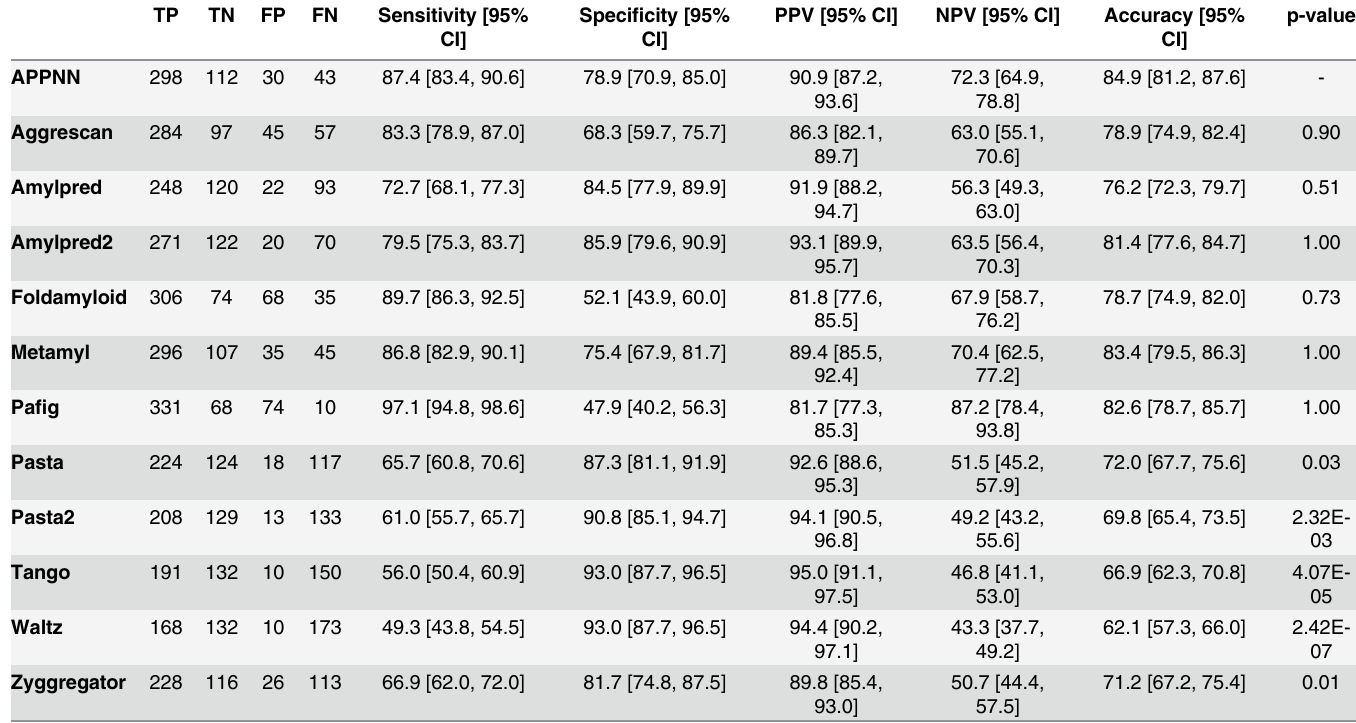
Table 4. Results obtained for the classification of the external validation sequence dataset for each predictor, where TP corresponds to the num- ber of true positives, TN to the number of true negatives, FP to the number of false positives and FN to the number of false negatives. The values of sensitivity, specificity, positive predictive value (PPV), negative predictive value (NPV) and accuracy, with corresponding 95% confidence intervals, were obtained using bootstrap replicates. The p-value corresponds to the p-value obtained for the comparison of the accuracy values between the APPNN and each given predictor using the Wilcoxon-Nemenyi-McDonald-Thompson post-hoc test performed after 10-fold stratified